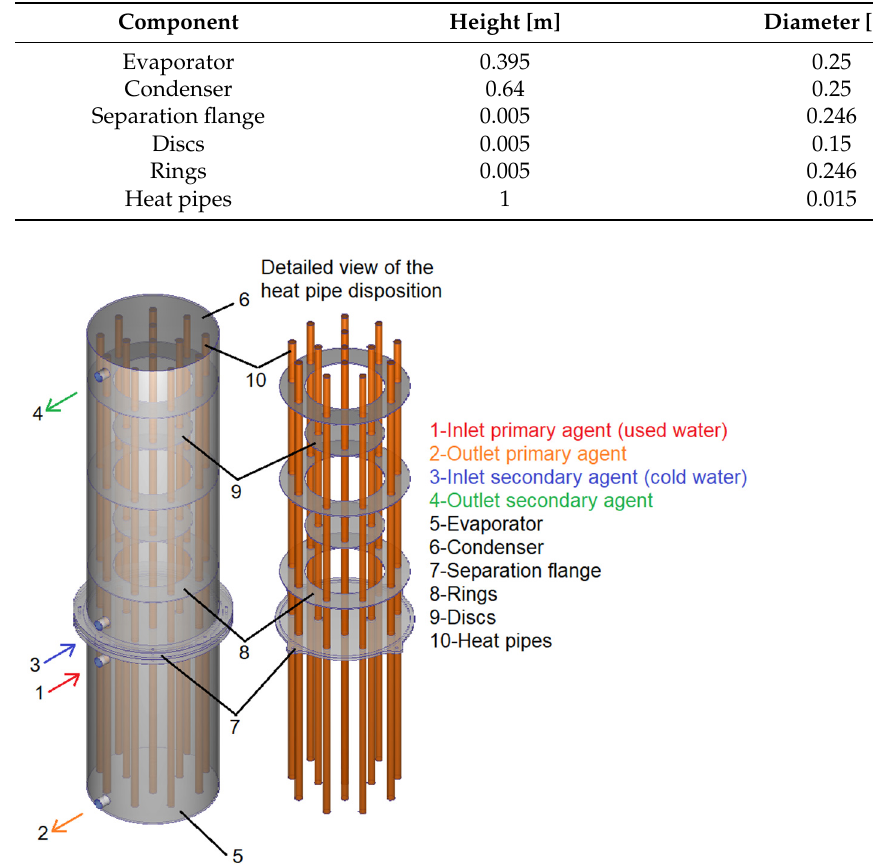
Table 1. Constructive details of the components.